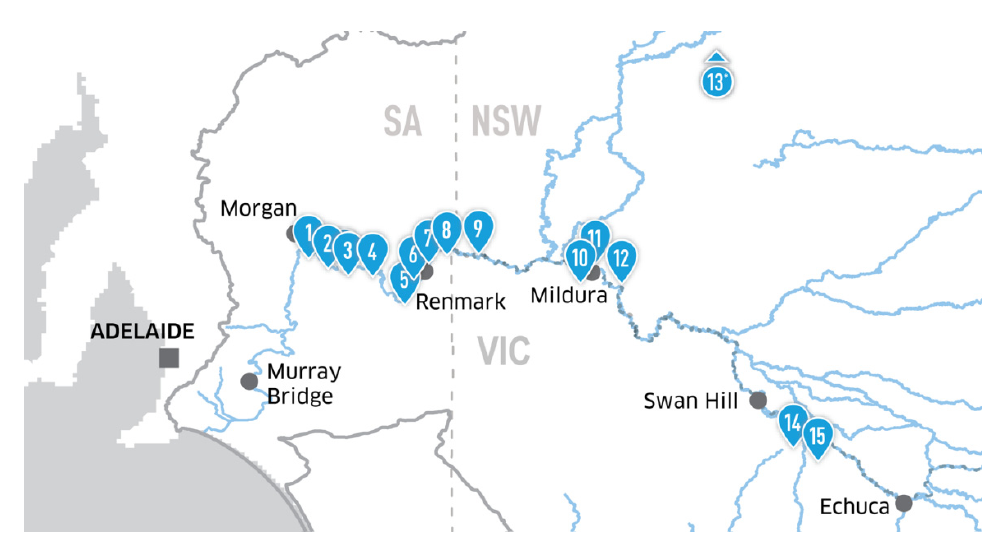
Figure 6. Map of the salt interception schemes in the lower River Murray and Darling River: 1. Waikerie 2A; 2. Waikerie (Lock 2); 3. Waikerie; 4. Woolpunda; 5. Loxton; 6. Bookpurnong; 7. Pike; 8. Murtho; 9. Rufus River; 10. Mildura-Merbein; 11. Buronga; 12. Mallee Cliffs; 13. Upper Darling; 14. Barr Creek; 15. Pyramid Creek. (Source: MDBA).